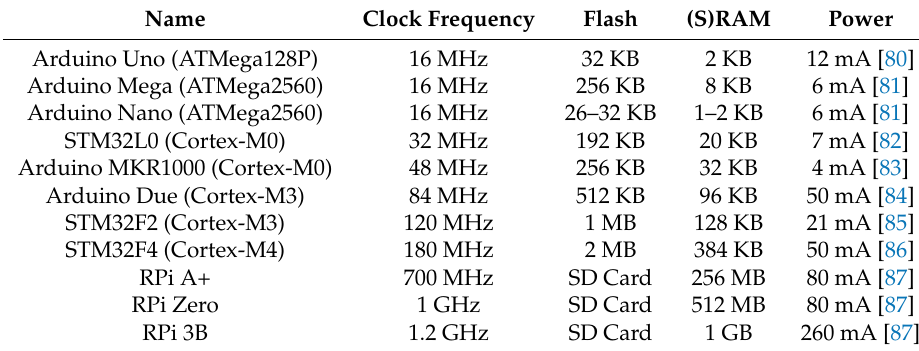
Table 1. Microcontroller units (MCUs) comparison. The table was ordered by the MCU’s clock